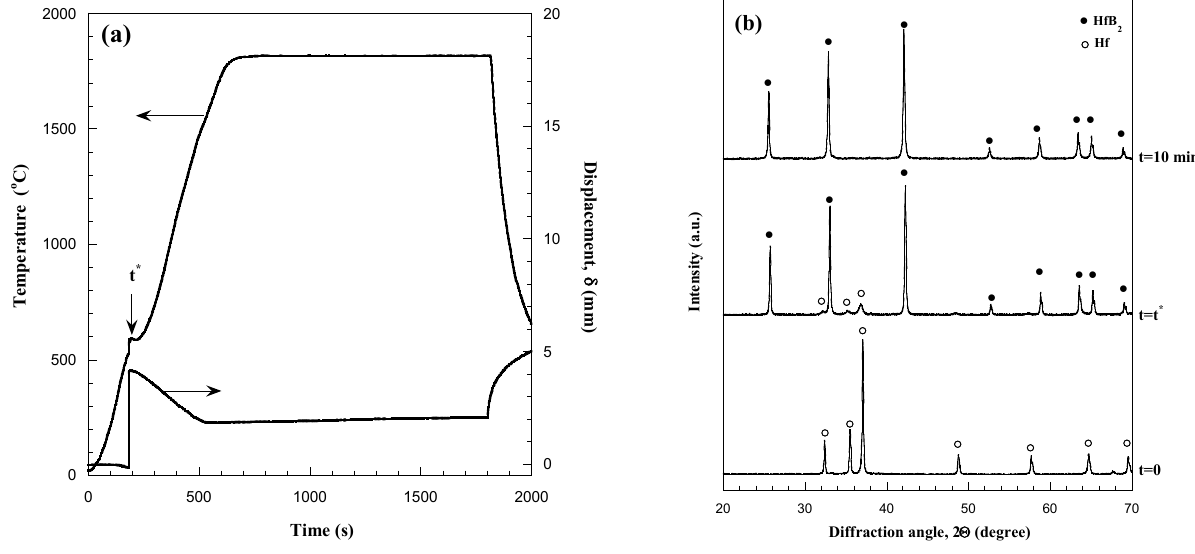
Figure 2. Temperature and displacement time profiles ( a ) measured during reactive SPS of and ( b ) related compositional changes. Adapted from HfB 2